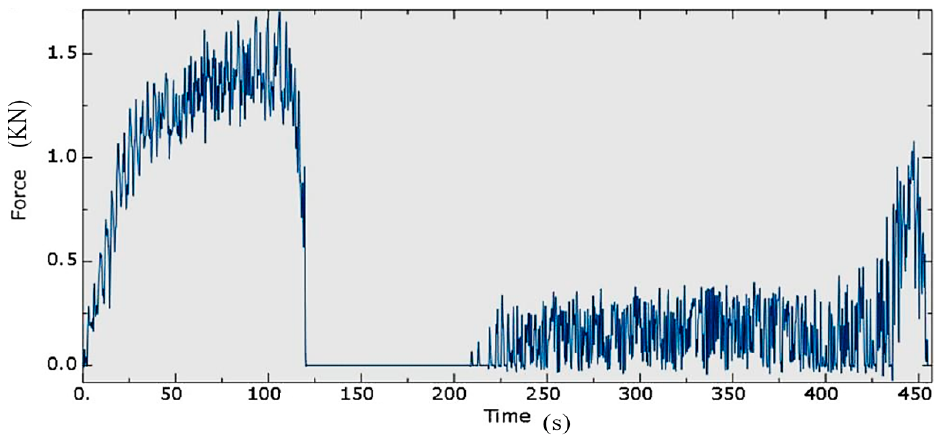
Figure 12. The forming force plot after optimisation.